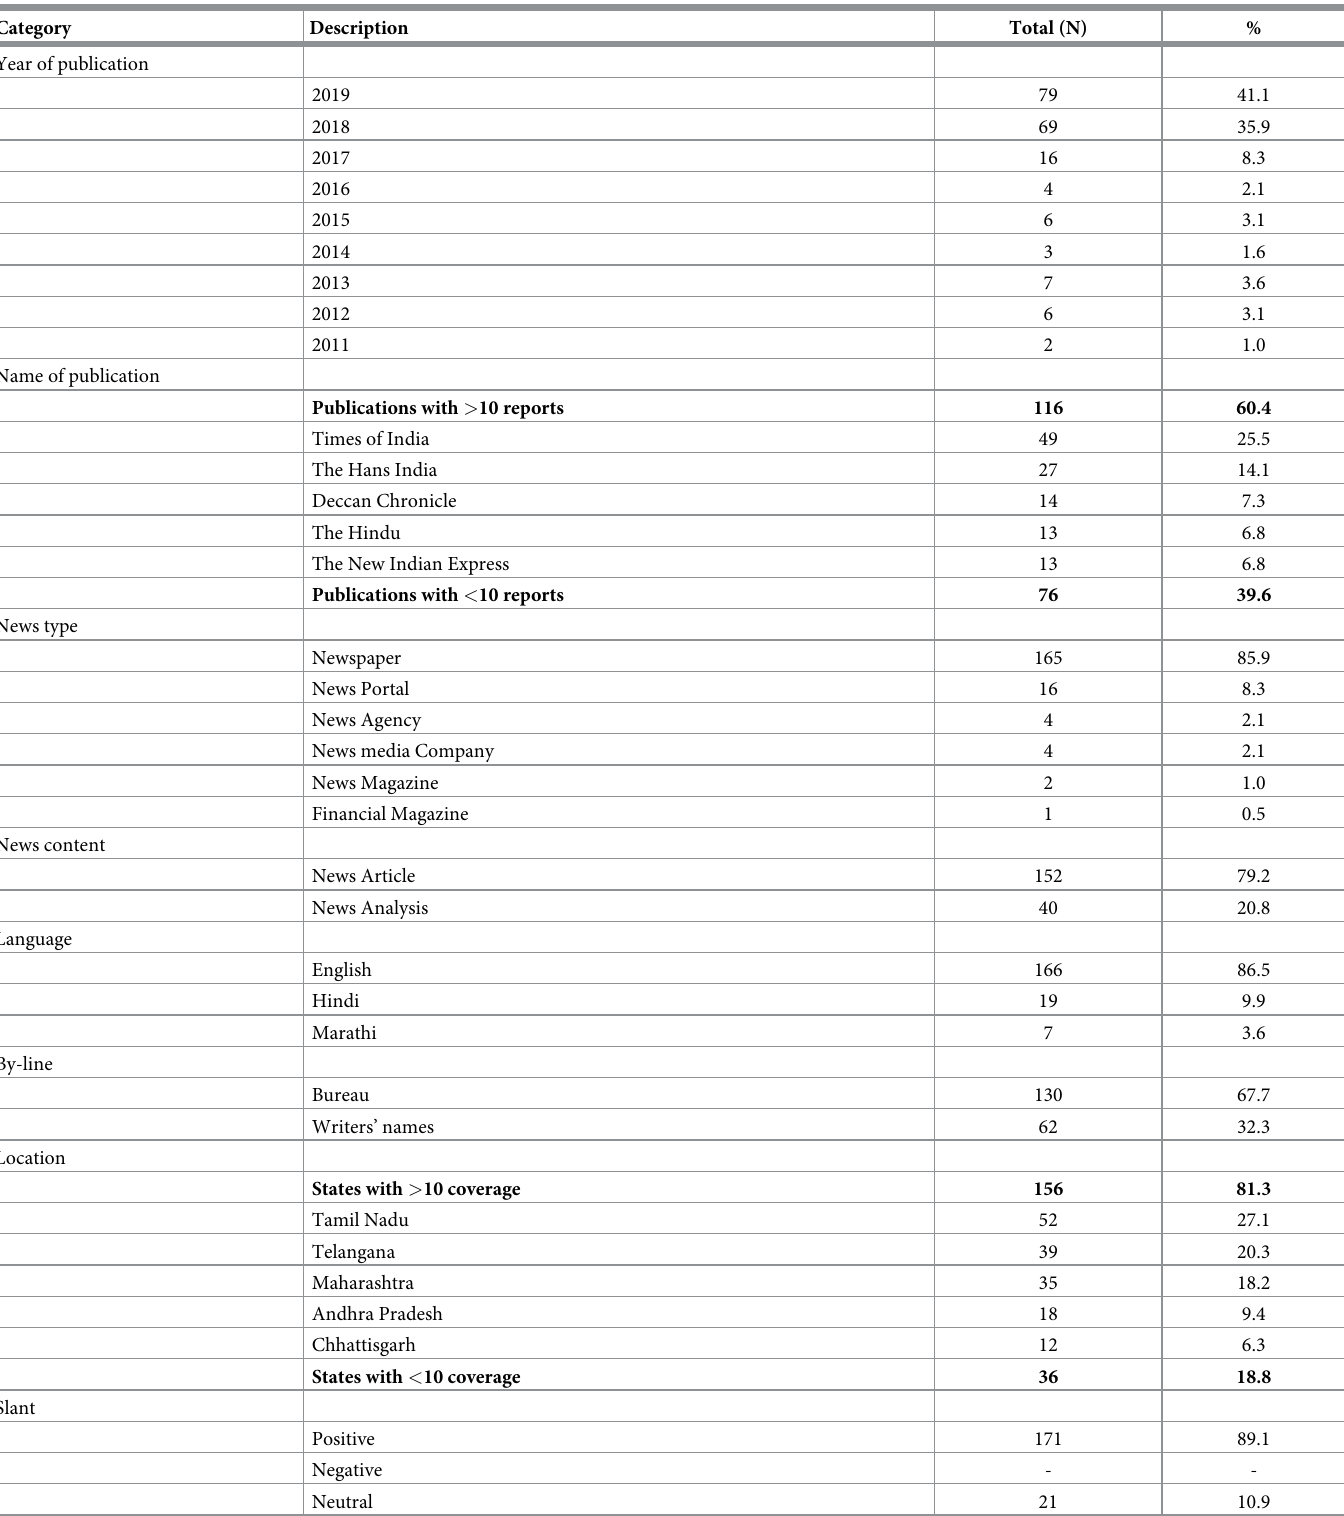
Table 2. Key characteristics of the eligible news reports.